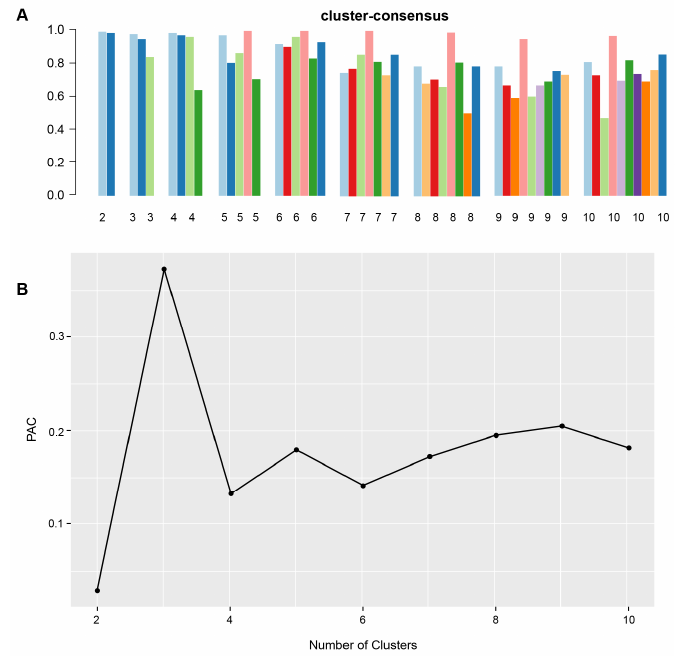
Figure 2. ( A ) The bar plot represents the mean consensus score for different numbers of clusters (K ranges from two to ten). Different colors indicate different cluster groups.; ( B ) the PAC values assess ambiguously clustered pairs. Table 1. Clinical characteristics according to clusters of non-U.S. citizen kidney transplant